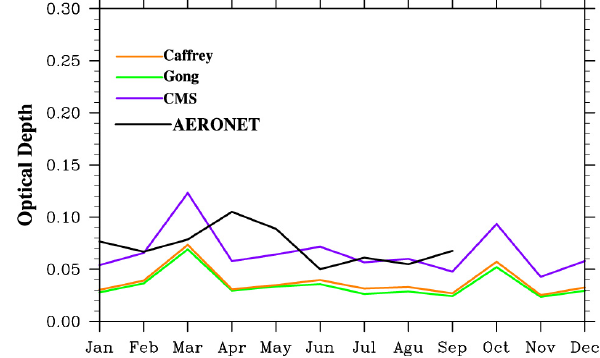
Fig. 8. Monthly averaged model and AERONET coarse-mode 500nm optical depths at Midway Island (28 ◦ N, 177 ◦ W) in 2006. Simulations using Gong, Caffrey, and CMS source functions are compared here using a solubility factor of